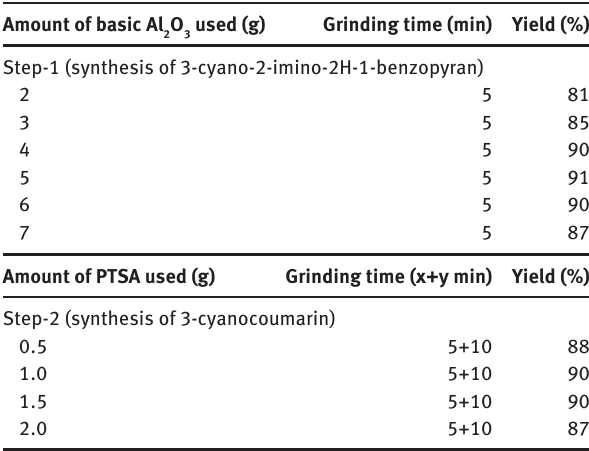
Table 1 Optimisation of the reaction conditions for the model reaction* at room temperature.